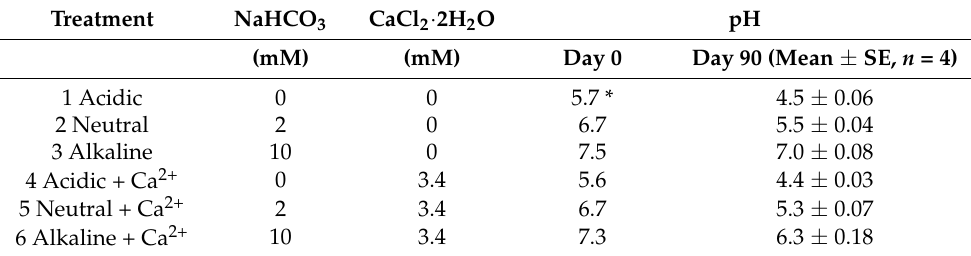
Table 1. Experiment 1: Overview of the medium pH after autoclaving at the start of and after 90 days (end of the experiment). The pH of the media decreased by around 1 unit, but the pH gradient was maintained. Treatment 1 is the control medium for seed germination and seedling development. Treatment NaHCO 3 CaCl 2 · 2H 2 O pH (mM) (mM) Day 0 Day 90 (Mean ± SE, n =